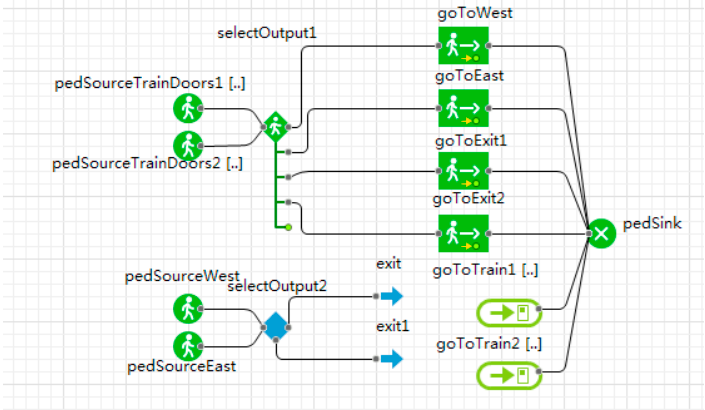
Figure 6. Simulation modeling of passenger